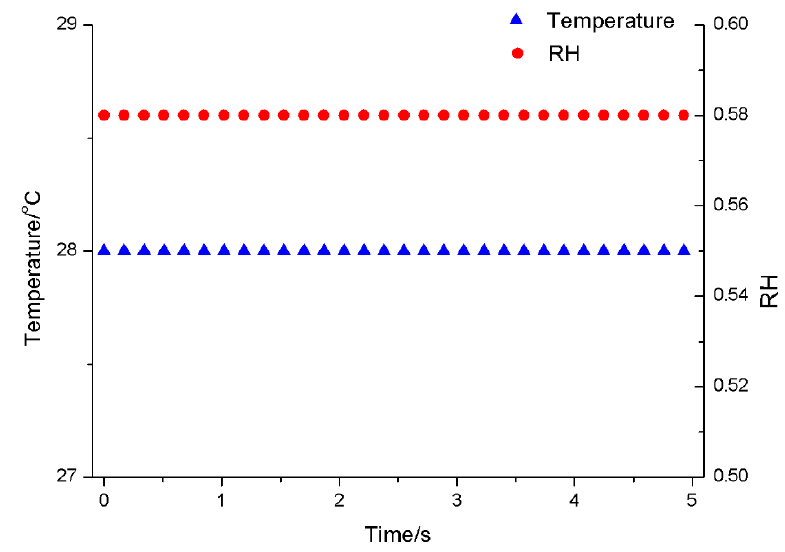
Figure 15. Received temperature and relative humidity